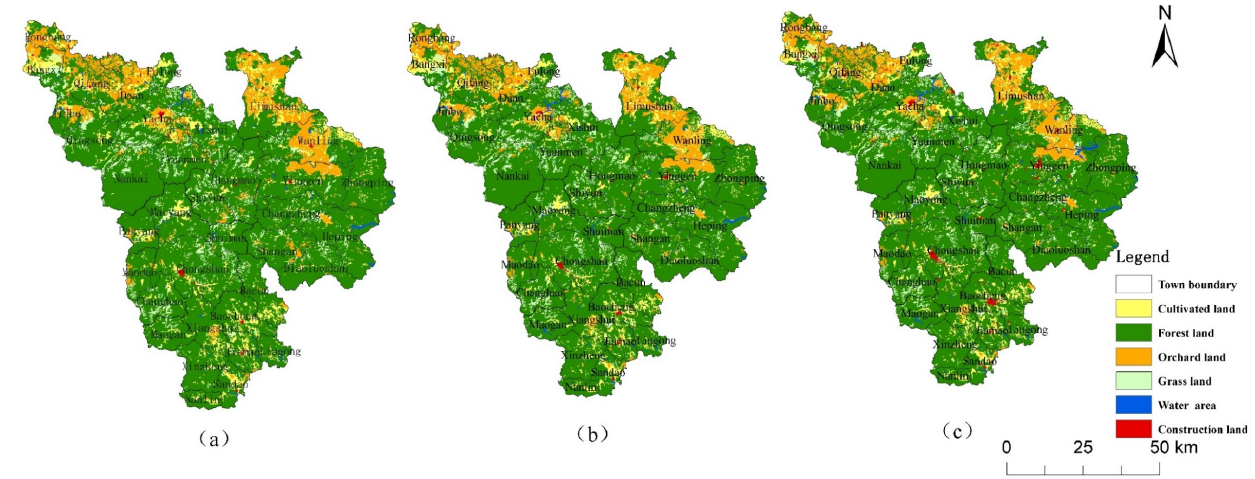
Figure 2. Land-use change in the CMA from 2000 to 2018. ( a ) 2000, ( b ) 2010, ( c ) 2018. Table 3. Land-use changes in CMA from 2000 to 2018.